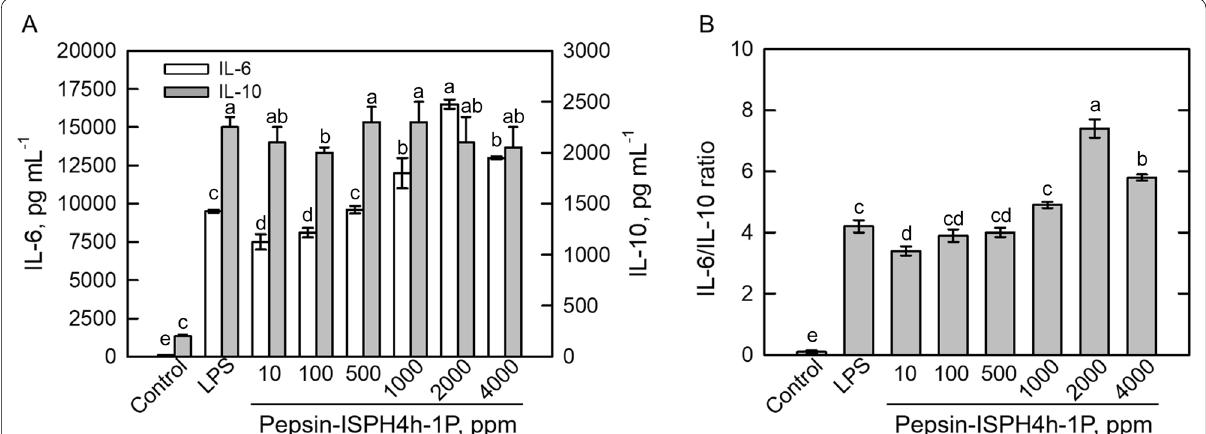
Fig. 4 Determination of pro‑inflammatory cytokines in LPS–Pepsin‑ISP4h‑1P‑costimulated RAW264.7 macrophage cells. A dosage effect of Pepsin‑ISPH4h‑1P with 1 ppm LPS co‑stimulation on IL‑6 (gray column) and IL‑10 (white column) productions. B dosage effect of Pepsin‑ISPH4h‑1P with 1 ppm LPS co‑stimulation on IL‑6/IL‑10 ratio. Bars represent mean different ( p < 0.05) by Duncan’s multiple range